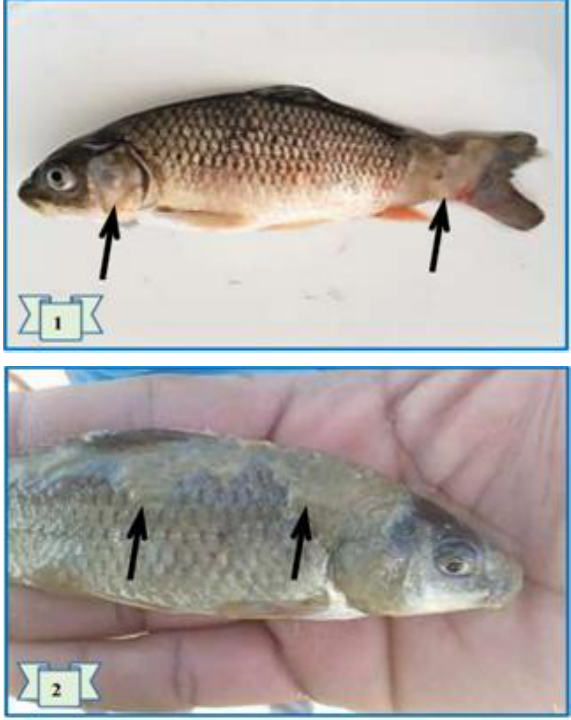
Figure, 3: Saprolegeniasis (Water mold disease). Grossly [1] and [2] show presence of white cotton like lesions at gills, dorsal fin and extended to tail fin